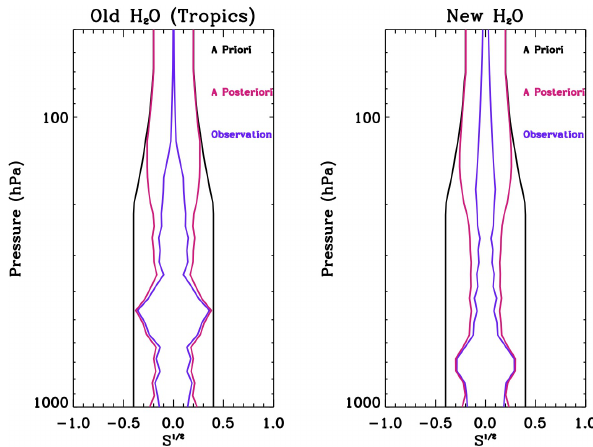
Figure 2b. The square root of the diagonal of the error covariances. The units are approximately the fractional uncertainty as the TES trace gas retrievals estimates the log of the concentrations. Observation error includes uncertainties from jointly retrieved parameters affecting the radiance and error due to noise. The a posteriori error covariance is the sum of the observation error and smoothing error